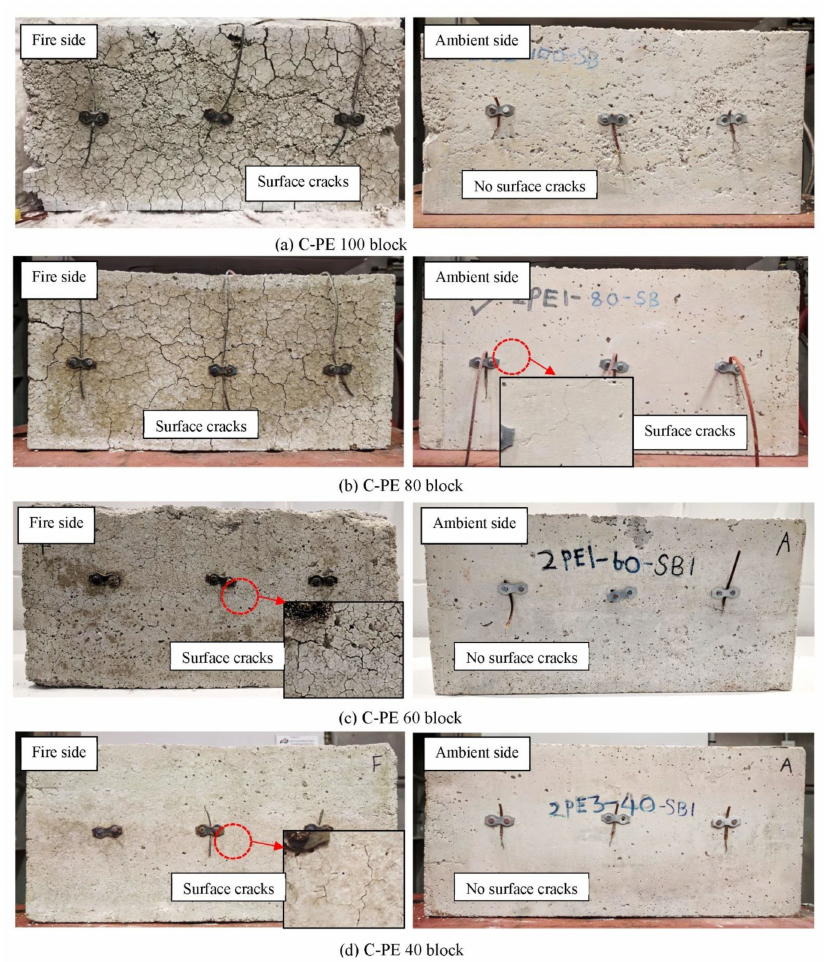
Figure 34. Fire-exposed and ambient side surfaces of C-PE blocks after the building fire